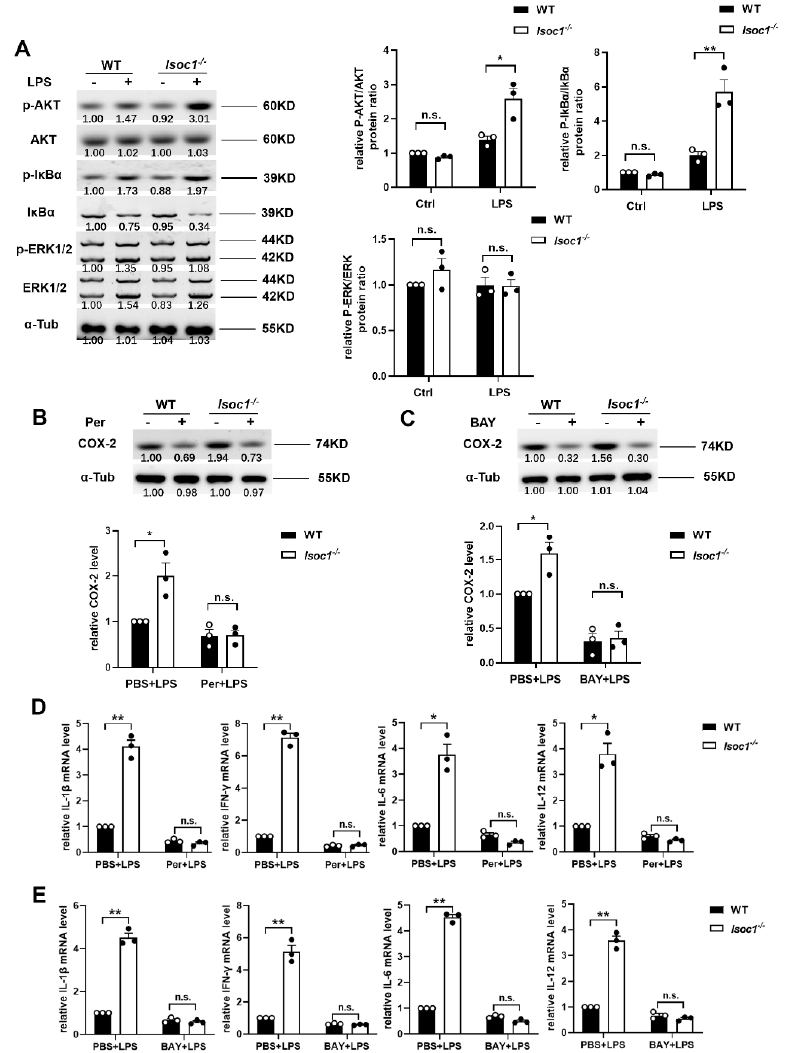
Figure 2. ISOC1 mediates macrophage inflammatory response via AKT1 and NF- κ B pathway. ( A ) Wild-type or ISOC1-deficient RAW264.7 cells were stimulated with 300 ng/mL LPS for 24 h. Cell lysates were collected, and western blotting was used to detect the phosphorylation levels of AKT1, I κ B α , and ERK. ( B , C ) ISOC1-deficient RAW264.7 cells were pretreated with 10 µ M Perifosine for 12 h ( B ) or 10 µ M BAY 11-7082 for 1.5 h ( C ) and stimulated with 300 ng/mL LPS for 24 h. Expressions of the COX-2 protein were detected by Western blotting. ( D , E ) Wild-type and ISOC1-deficient RAW264.7 cells were pretreated with 10 μ M Perifosine for 12 h ( D ) or 10 μ M BAY 11-7082 for 1.5 h ( E ) and stimulated with 300 ng/mL LPS for 24 h. qRT-PCR was used to detect the expression levels